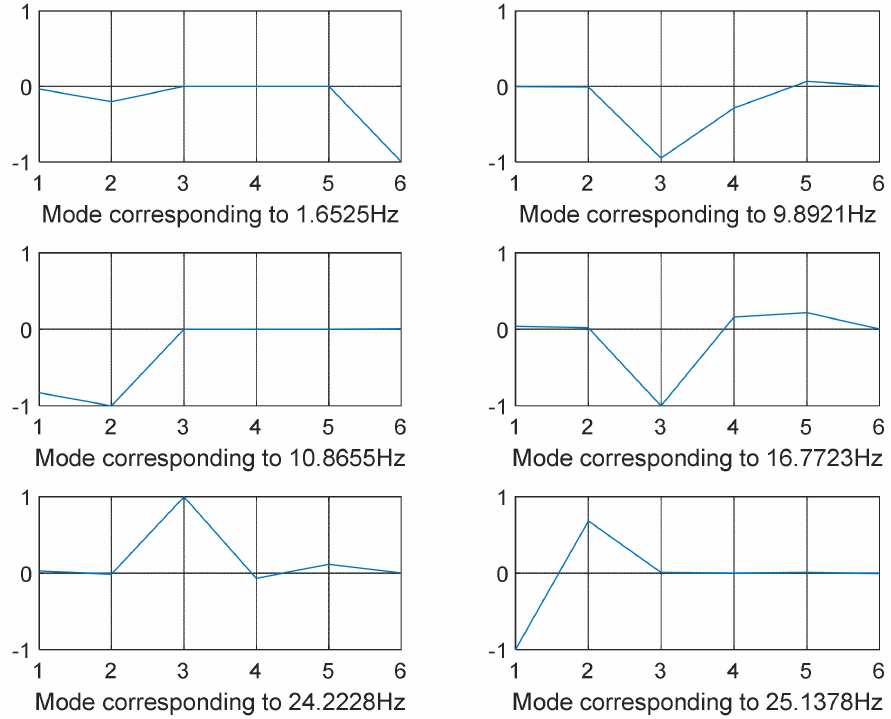
Figure 5. GA-optimized mode shapes 1–6 (12-DOF model—shaking loads